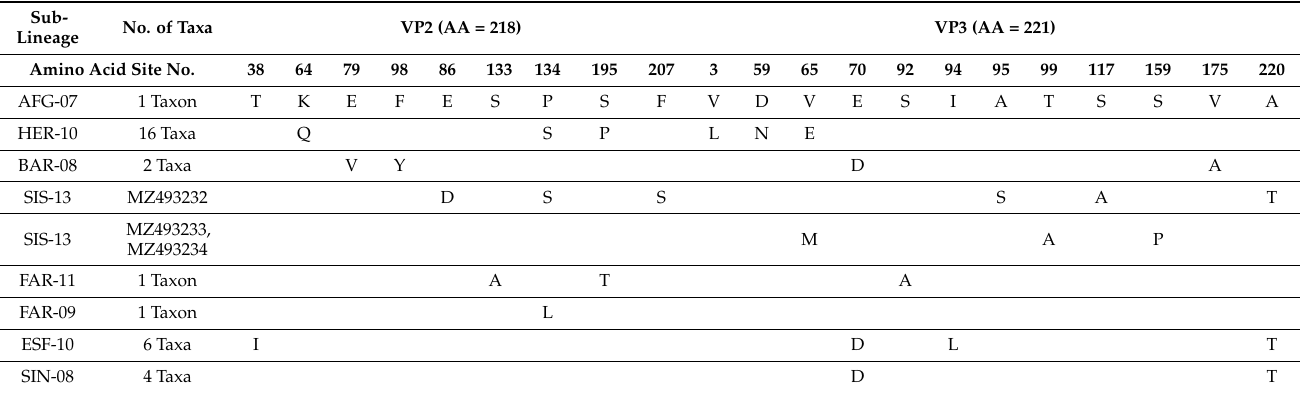
Table 1. A comparison of non-synonymous amino acid substitutions in the capsid proteins VP2 and VP3 of eight sub-lineages of A/ASIA/Iran-05.